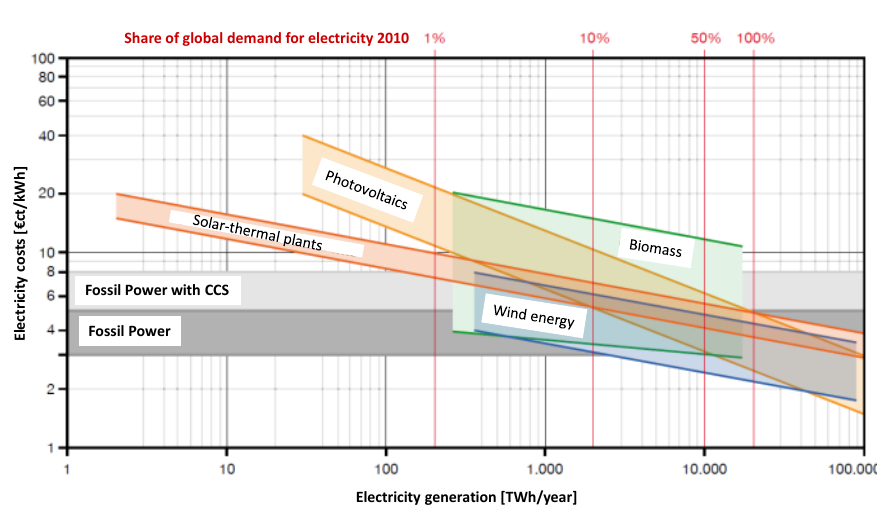
Fig. 2. Development potential of the costs of electricity from renewables Source: WBGU ((2011, p.